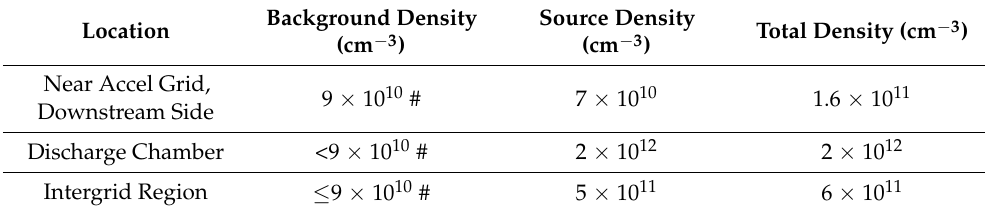
Table 2. Rough estimates for average DTL28-H-H background and source densities. Background Density Source Density Total Density (cm − 3 ) Location (cm − 3 ) (cm − 3 ) Near Accel Grid, 9 × 10 10 # 7 × 10 10 1.6 × 10 11 Downstream Side Discharge Chamber <9 × 10 10 # 2 × 10 12 2 × 10 12 Intergrid Region ≤ 9 × 10 10 # 5 × 10 11